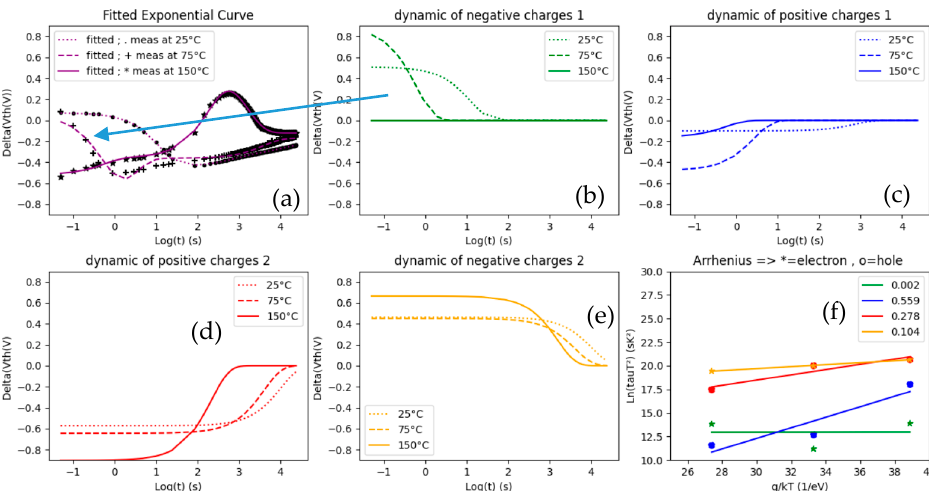
Figure 9. Design B wafer 2; ( a ) measurement at 25, 75 and 150 °C; ( b ) extraction of dynamic first level of negative charges; ( c ) extraction of dynamic first level of positive charges; ( d ) extraction of dynamic second level of negative charges; ( e ) extraction of dynamic second level of positive charges; ( f ) report of the four levels of charge in an Arrhenius graph (extraction of energy levels). Subfigures ( a – e ), show the Vth shift due to one trap level in function of time measured at 25, 75 and 150 °C. Subfigure ( f ) is the extraction of traps energies levels for each trap level.